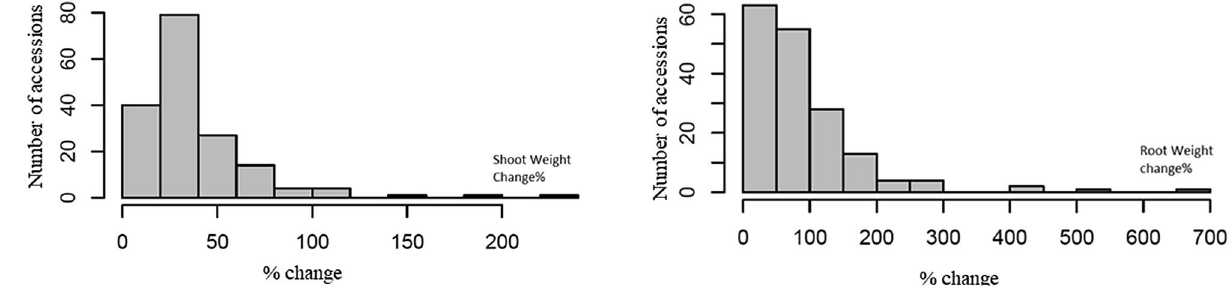
Figure 1. The distribution of percent changes in the shoot ( A ) and root ( B ) weight (biomass) across spinach accessions. Forty-one-day plants were harvested for the shoot and root biomass and expressed as % change (100 × LN/HN; shown on the horizontal axis) for 201 accessions (vertical axis).